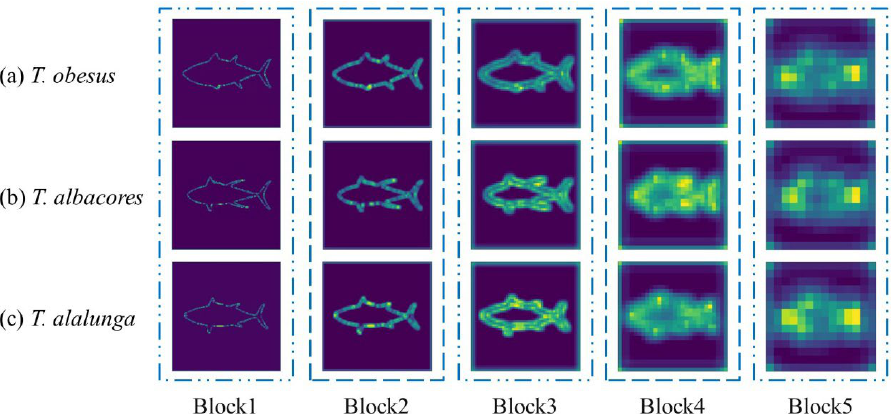
Figure 4. Visualization of three Thunnus species with deep convolutional neural networks.